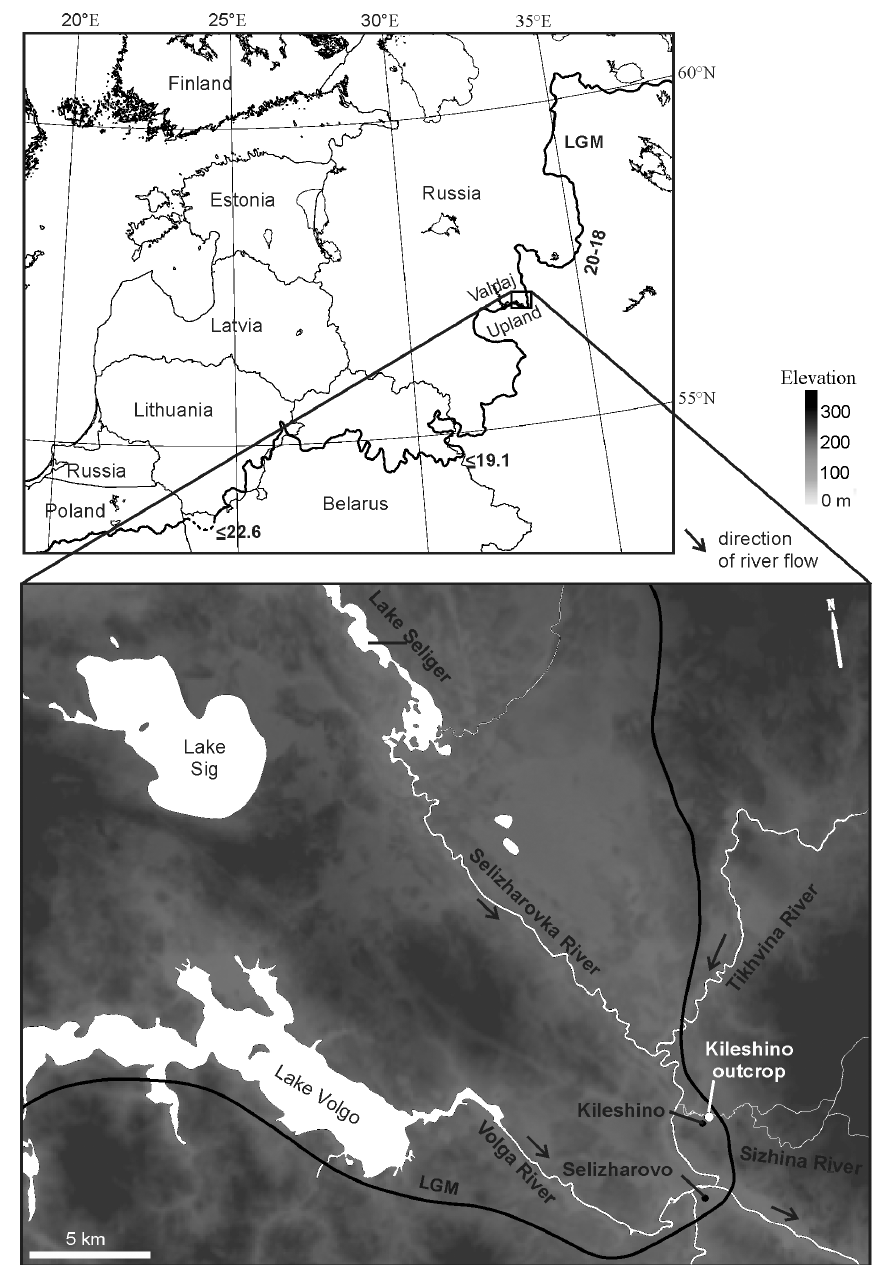
Fig. 1. Location of the Kileshino outcrop. Last Glacial Maximum (LGM) ages are based on Lasberg & Kalm (2013) and Demidov et al.